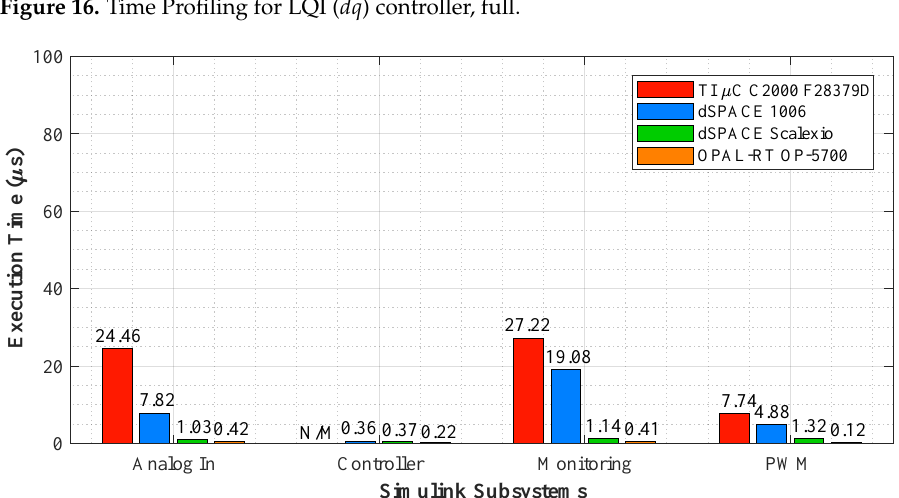
Figure 17. Time Profiling for LQI ( dq ) controller,